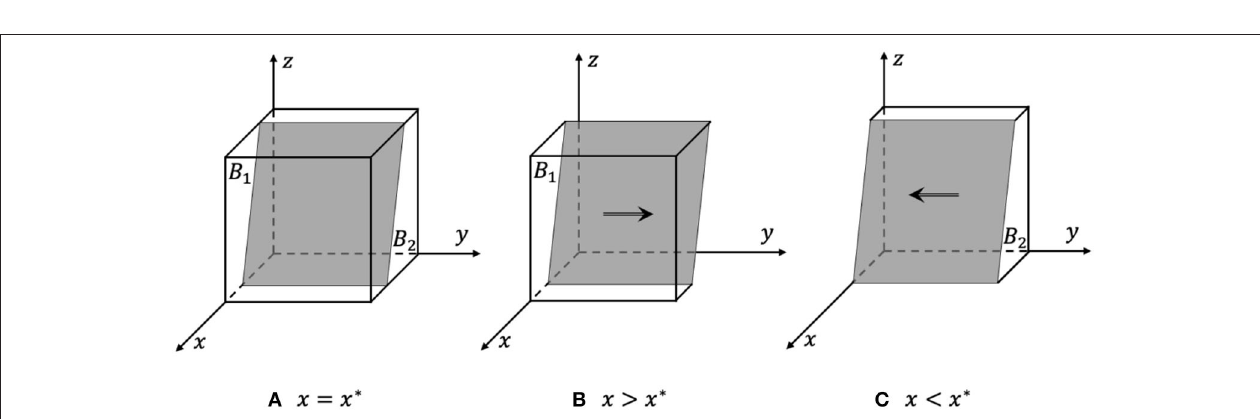
FIGURE 3 | Phase diagram of e-commerce platforms’ strategy evolution. (A) x = x*, all strategies are in a stable state. (B) x > x*, y = 1 are the evolutionarily stable strategy. (C) x < x*, y = 0 are the evolutionarily stable